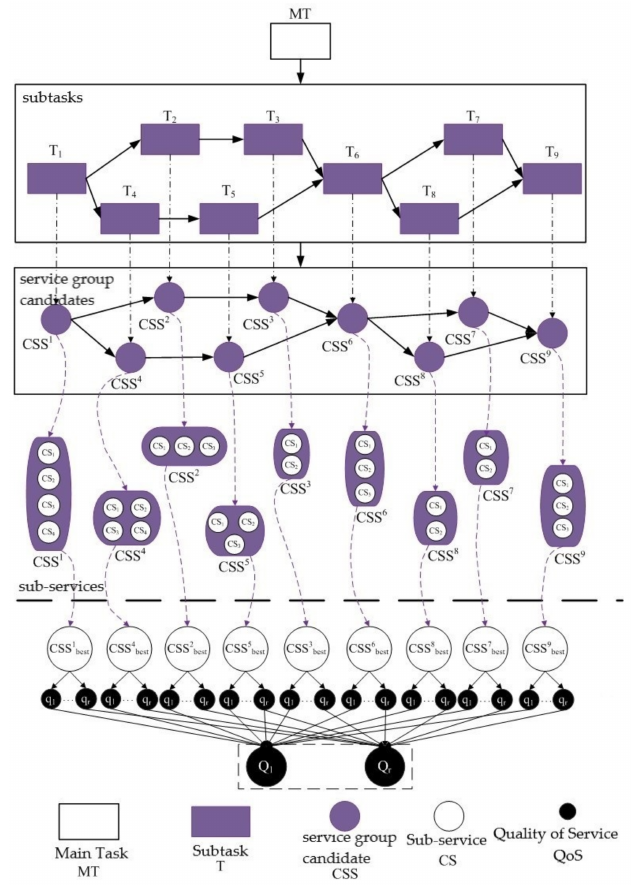
Figure 1. Service composition process in traditional